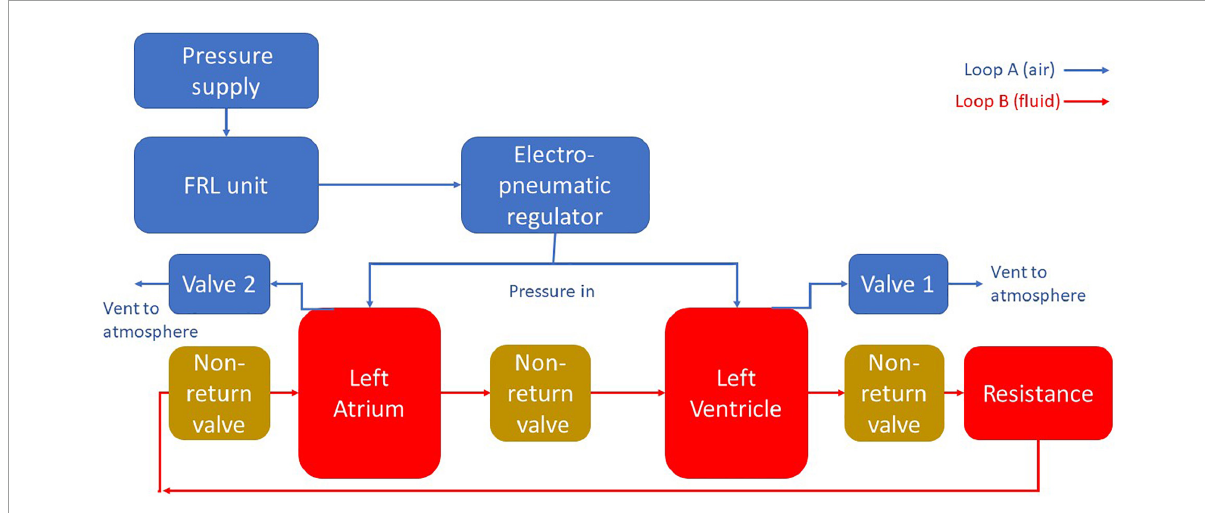
FIGURE1 A schematic diagram of the MCL apparatus. Pressure is delivered to the chambers using pneumatic regulation. The flow in the blood loop is achieved by selectively pressurizing and depressurizing the heart chambers using solenoid valves. Backflow is prevented through the use of non-return valves.